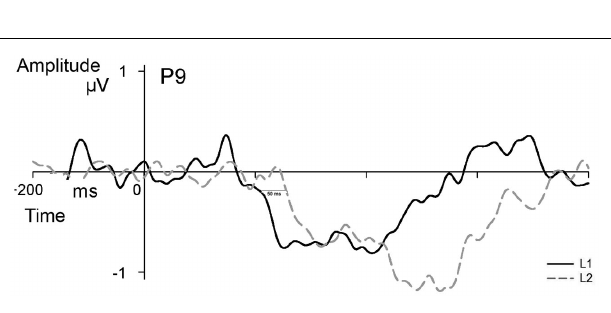
Topographic Maps (fixed scaling between − 1 and 1 μ V) represent Differences in Activation between emotion-laden (positive or negative) and neutralWords.